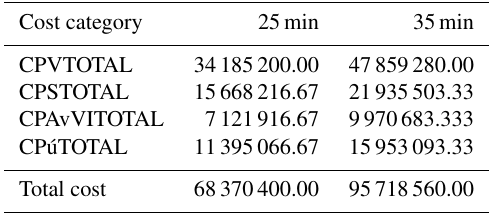
Table 5. Cost category expressed in delays of 25 and